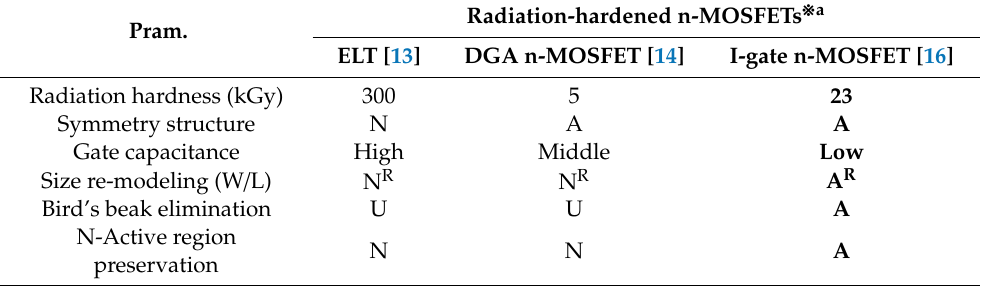
Table 3. Comparison of the characteristics of conventional bulk process radiation-hardened n-MOSFETs and the I-gate n-MOSFET.